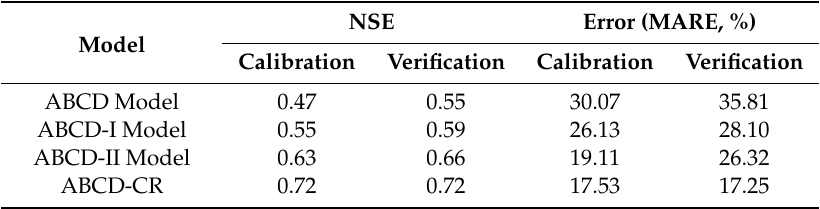
Figure 6. Monthly runoff results of the study catchment in the calibration and validation period obtained from the ABCD-CR model. Table 3. Performance of models in calibration and validation periods.